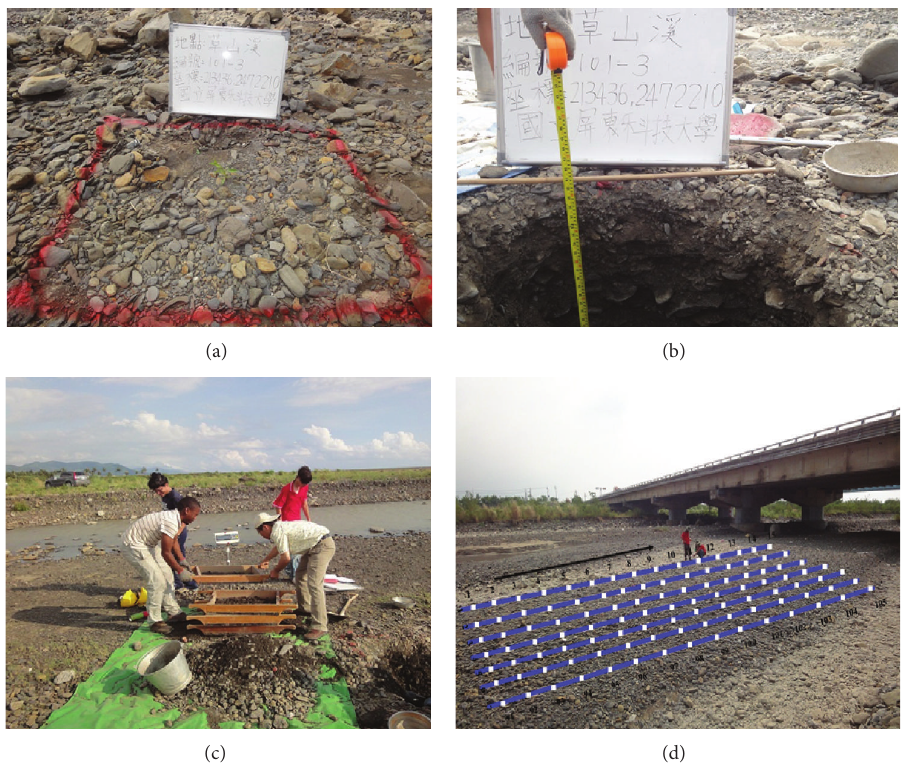
Figure 3: Illustration of volumetric and grid sampling methods. (a) A sampling perimeter of one square meter. (b) Vertical section of one meter. (c) Use of hand sieving to separate subsurface particles. (d) Grid